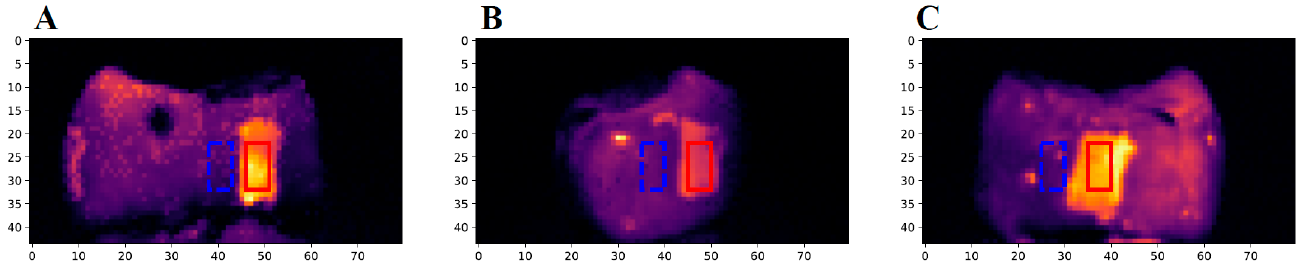
Figure 4. The first slices of the eTC-PCT amplitude images of sample B8: The three images show the ( A ) buccal, ( B ) distal, and ( C ) lingual surfaces of the sample. The red rectangle (10 × 5 pixels) highlights the region of the caries lesion used to determine the carious signal response of the sample, and the dashed blue rectangle (10 × 5 pixels) highlights a nearby sound region used as the reference for the sound enamel signal.